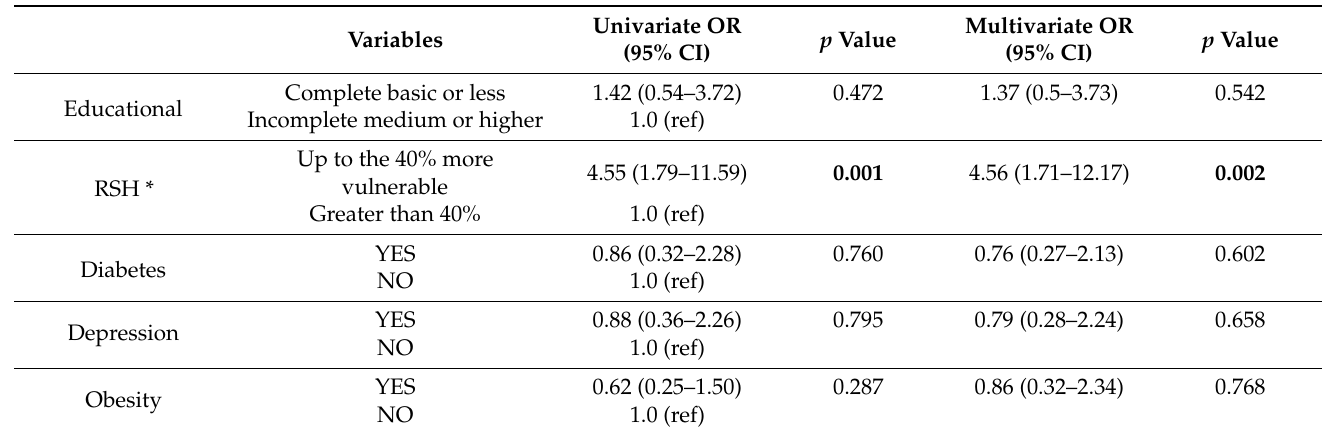
Table 3. Non-Adjusted and Adjusted odds ratios (ORs) and 95% confidence interval (95% CI) with the respective p values related to tooth loss (the presence of less than 21 teeth in mouth) for the ≥ 60-year-old group.